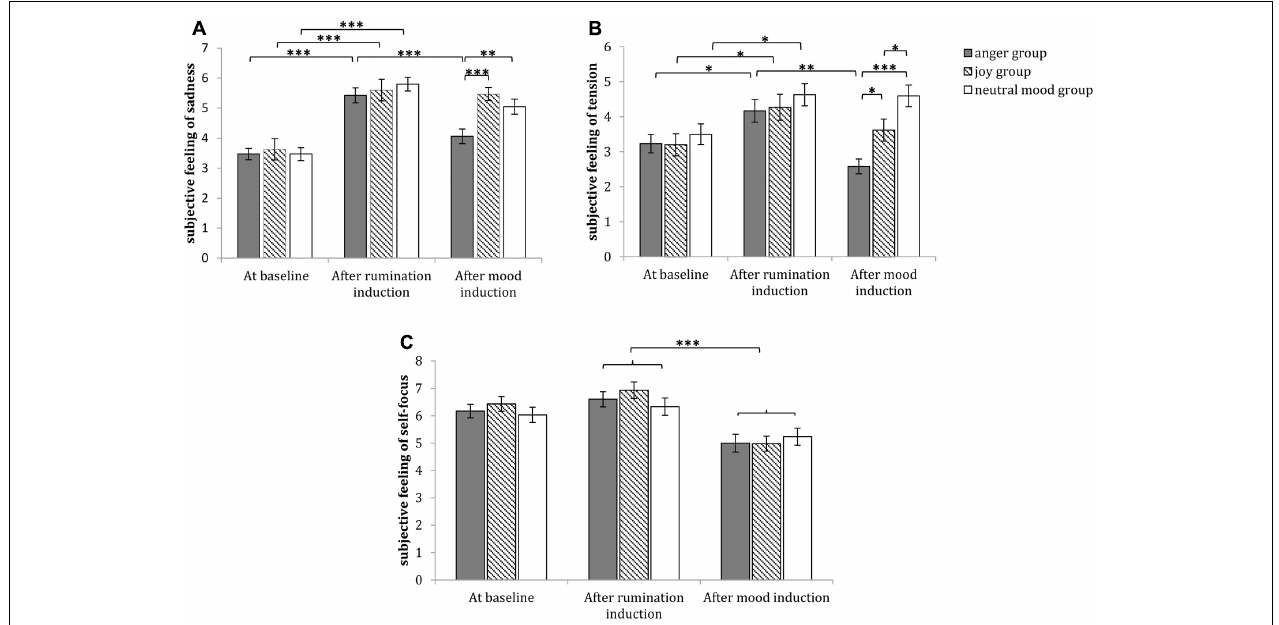
FIGURE 4 | Comparisons of emotional changes in the anger group, joy group and neutral group in Study 1. The subjective feelings of sadness at baseline, after rumination induction and after mood induction are shown in (A) . The subjective feelings of tension at baseline, after rumination induction and after mood induction are demonstrated in (B) . The subjective feelings of self-focus at baseline, after rumination induction and after mood induction are demonstrated in (C) , and the self-focus level after rumination induction was marginally significantly higher than that at baseline ( p = 0.058). Error bars (capped vertical bars) represent (–1)/(+1) SE